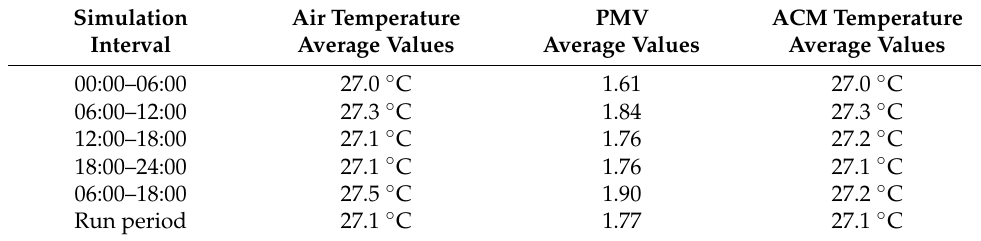
Figure 15. The indoor output of air temperatures and PMV as a result of retrofitting actions: ( a ) The simulated flat for the Materdei building; ( b ) The simulated flat for the Ponticelli building. For the Ponticelli building under analysis, the results obtained indicate how both the average internal temperatures of 27.1 ◦ C, with an average reduction of 20.0%, and the feeling of comfort in the PMV values that stand at 1.77, with an average reduction of 24.3%, define a decidedly improving condition. The ACM recorded the average temperature at 27.1 ◦ C (Table 14 and Figure 15). Table 14. Indoor environmental analysis data for the Ponticelli building as a result of retrofitting actions.